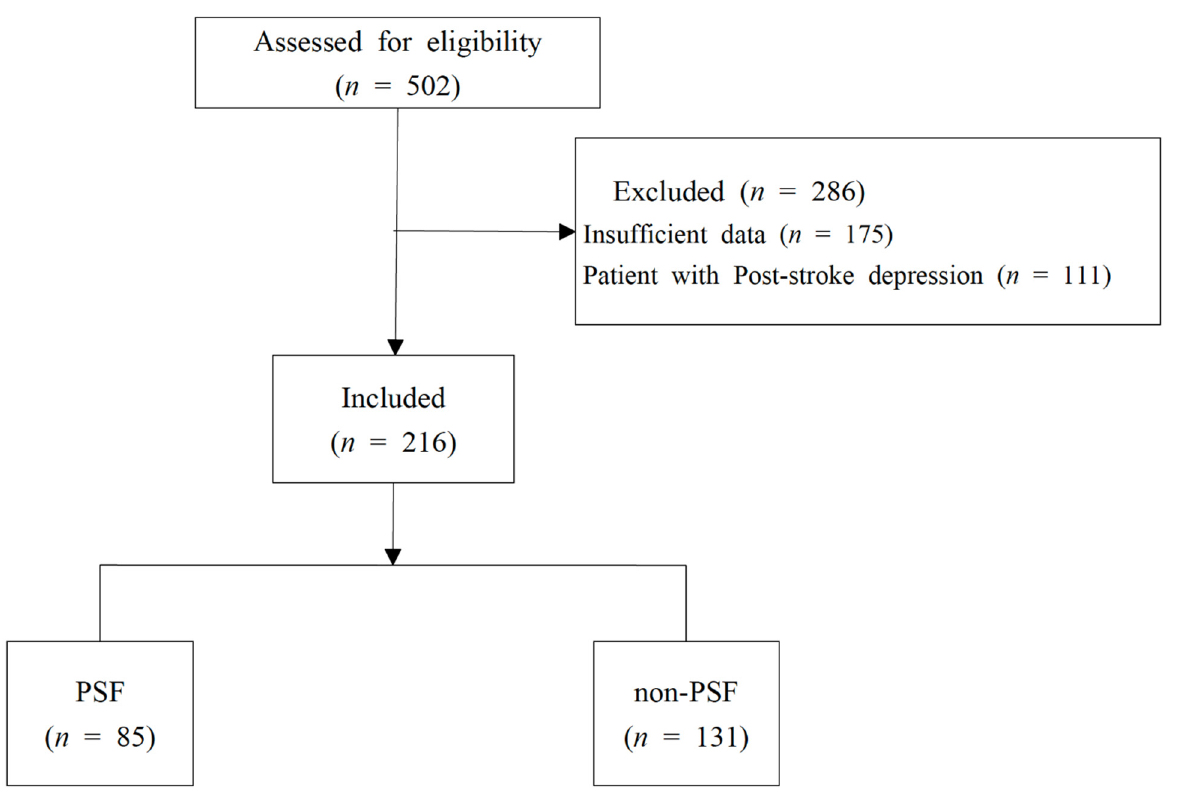
Figure 1. Flowchart of patient inclusion. PSF group: patients with post-stroke fatigue. Non-PSF group: patients without post-stroke fatigue.